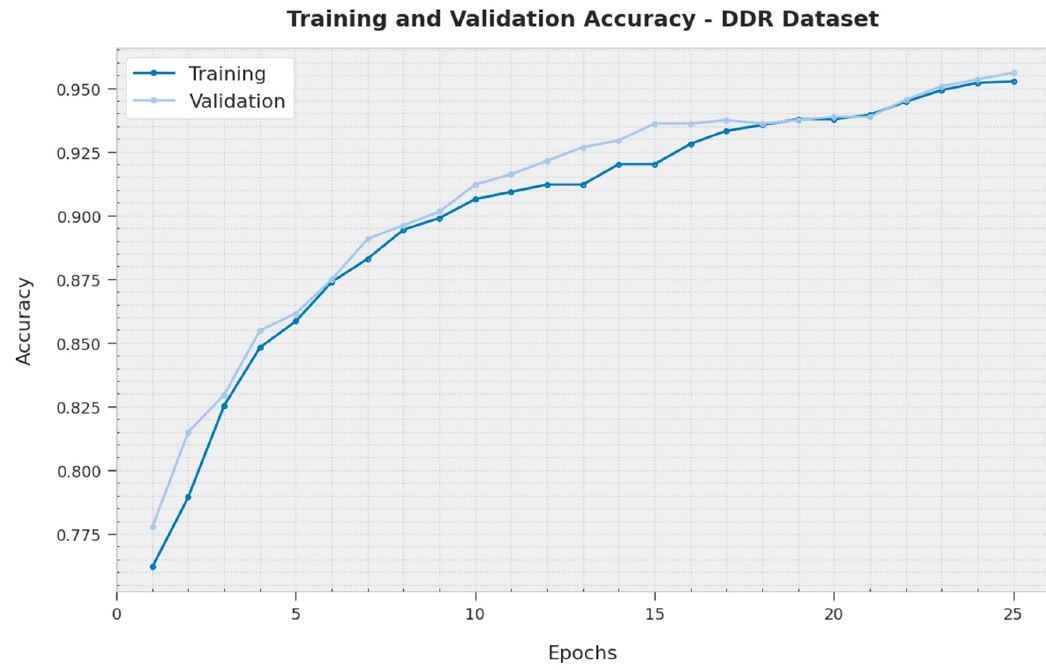
Figure 10. TA and VA analysis of the XAITO-DRGC approach under the DDR dataset.